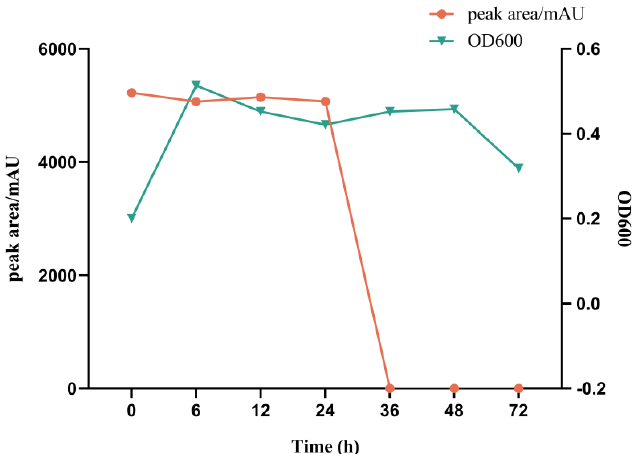
Figure 6. Degradation of nicotine by bacteria BsNLG8. The figure shows the changes in the concen- tration of bacteria, BsNLG8 in nicotine culture and the concentration of nicotine as the time pro- gressed.